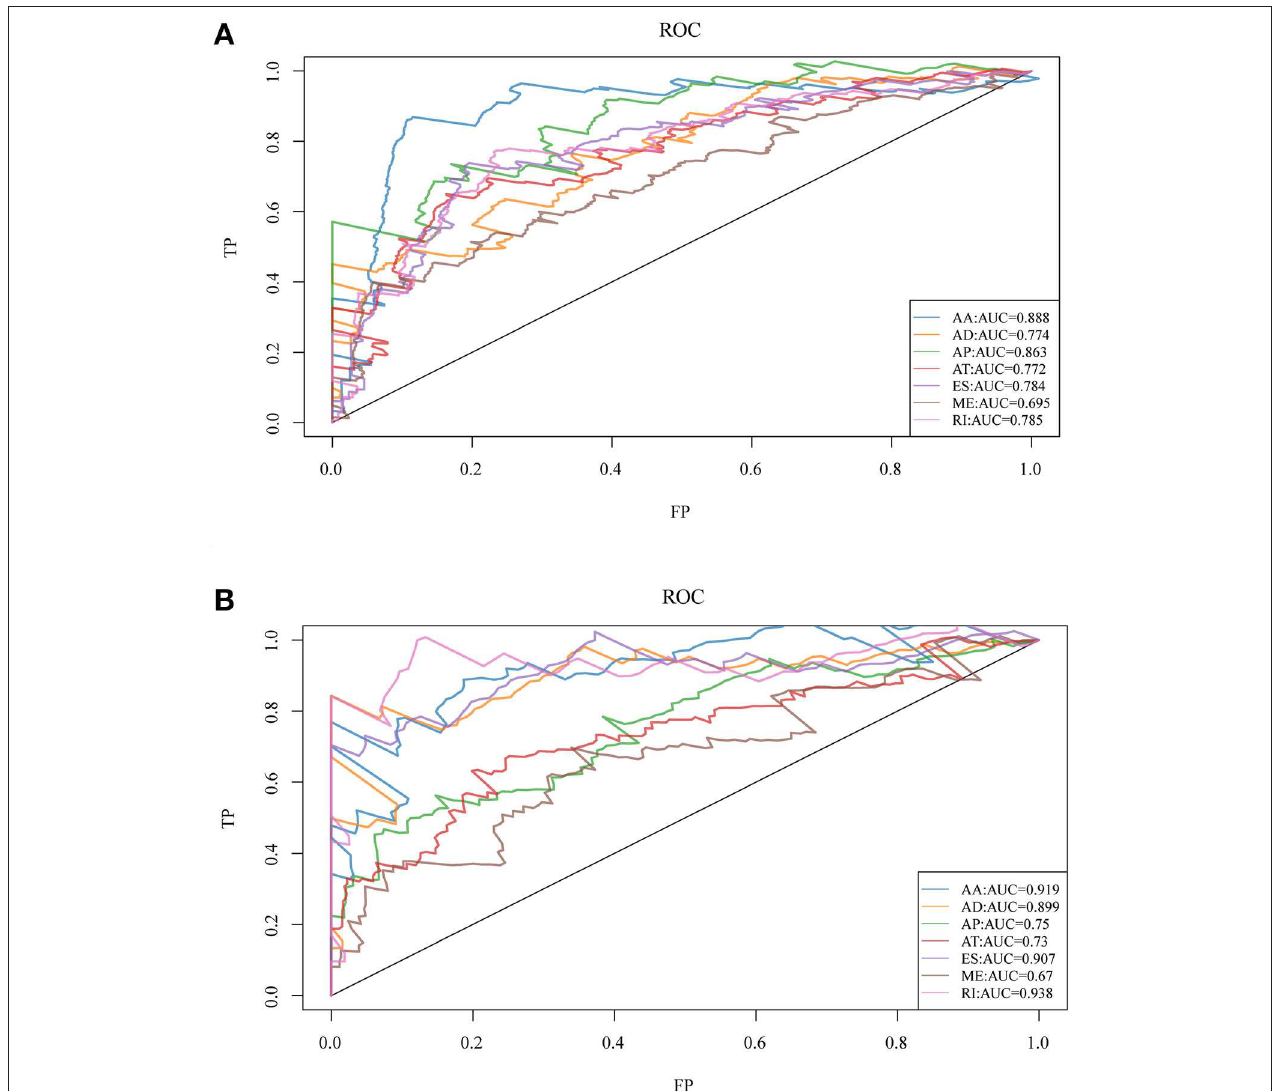
FIGURE 3 | ROC curves for OS (A) and recurrence (B) -associated AS events of each type for HNSCC patients.